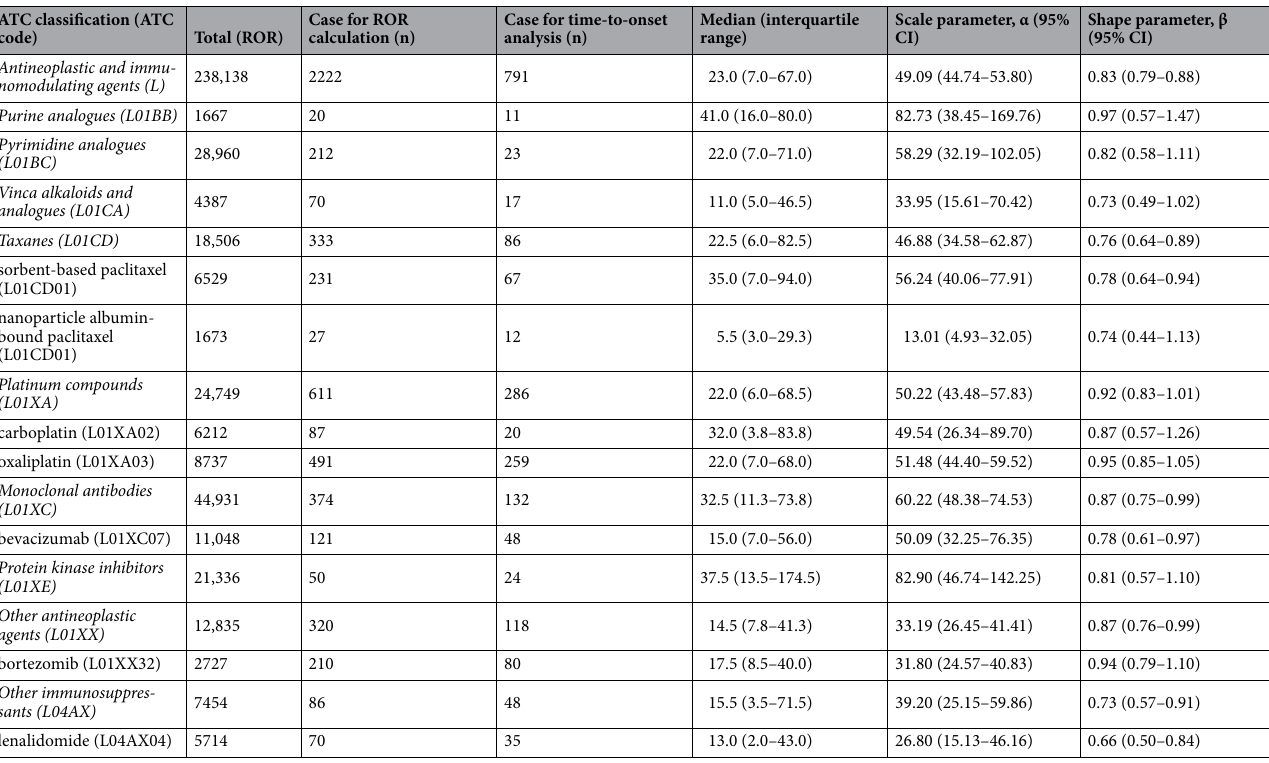
Table 2. The medians and Weibull parameter of chemotherapy-induced peripheral